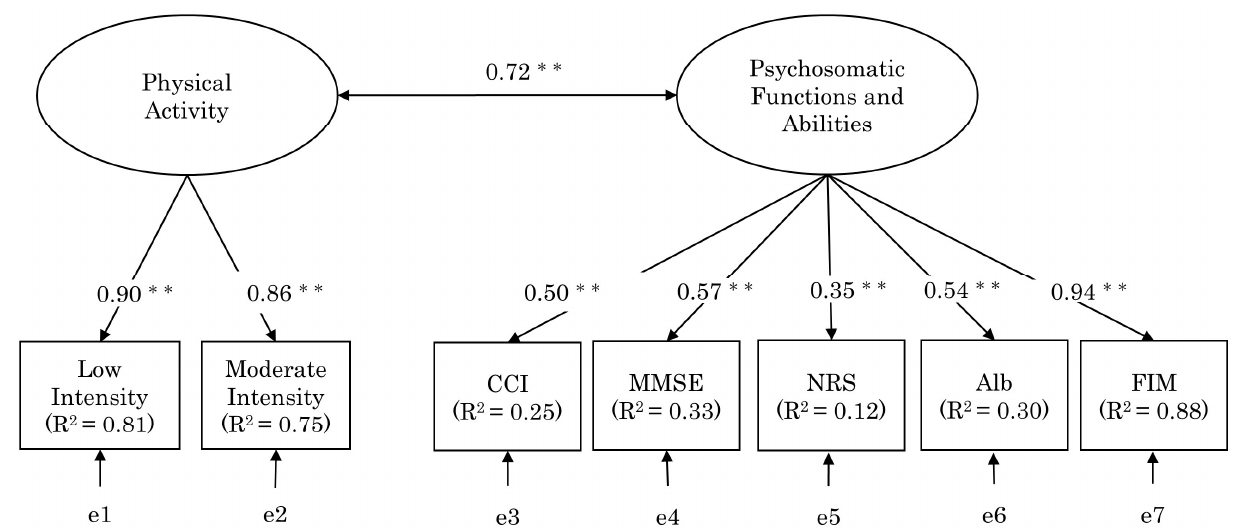
Figure 2. Confirmatory factor analysis of functioning and disabilities. CCI: Charlson Comorbidity Index, MMSE: Mini-Mental State Examination, NRS: Numerical Rating Scale, Alb: serum albumin test, FIM: functional independence measure, PES-J: Patient Empowerment Scale—Japanese Version. **: p < 0.01.